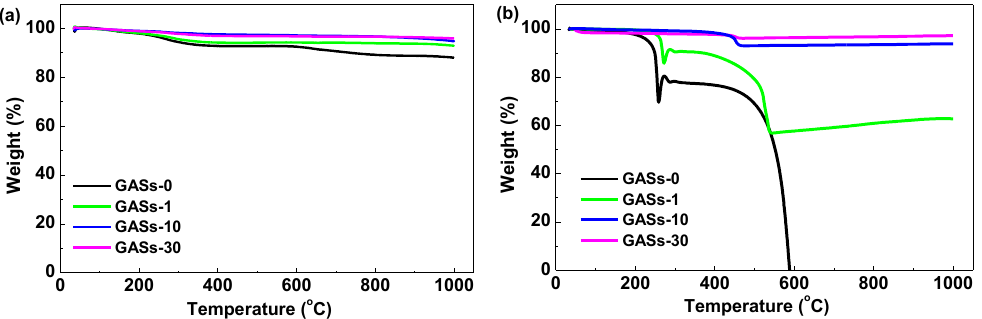
Figure 7. Thermogravimetric-analysis (TGA) tests for thermal-stability investigation of GSAs ( a ) under N 2 atmosphere and ( b ) in air.